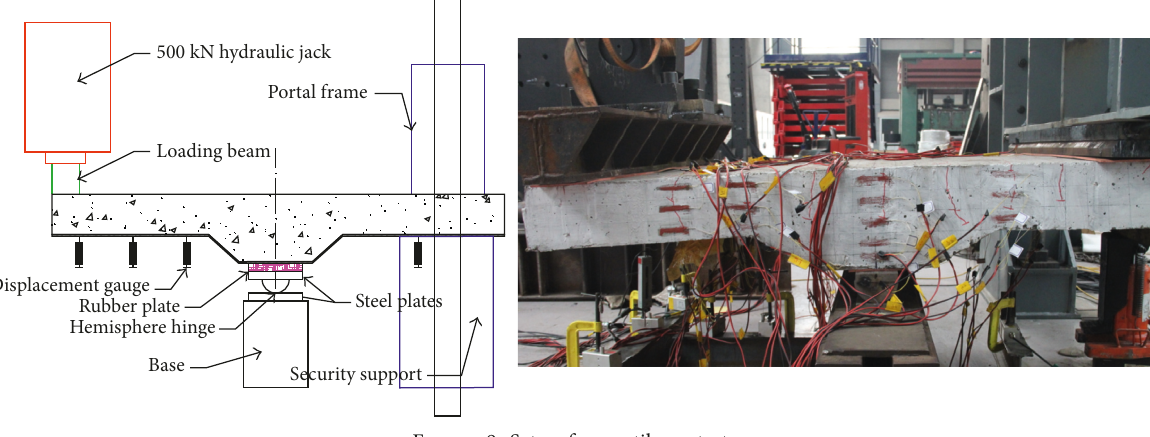
Figure 9: Setup for cantilever tests.